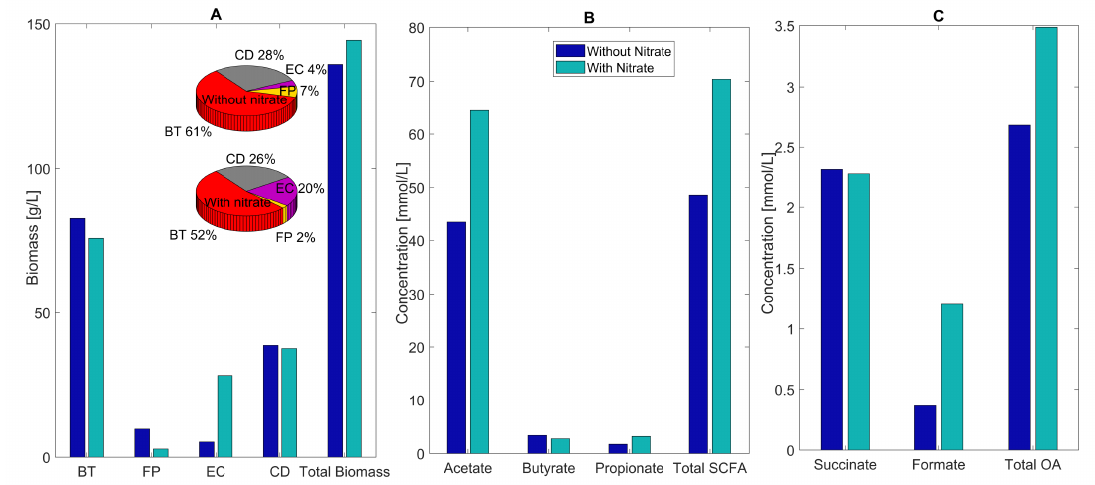
Figure 5. Predicted multispecies biofilm dysbiosis with and without host-derived nitrate. ( A ) Biomass concentrations (bar graphs) and species abundances (pie charts) averaged across the biofilm for the healthy and dysbiosis case. ( B ) Acetate, butyrate, propionate, and total SCFA concentrations (mmol/L) averaged across the biofilm. ( C ) Succinate, formate, and total OA concentrations averaged across the